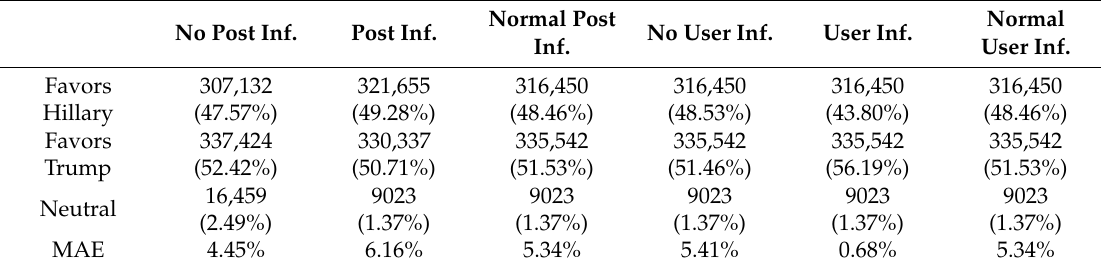
Table 5. Performance comparison for di ff erent user / post influence scores. No Post